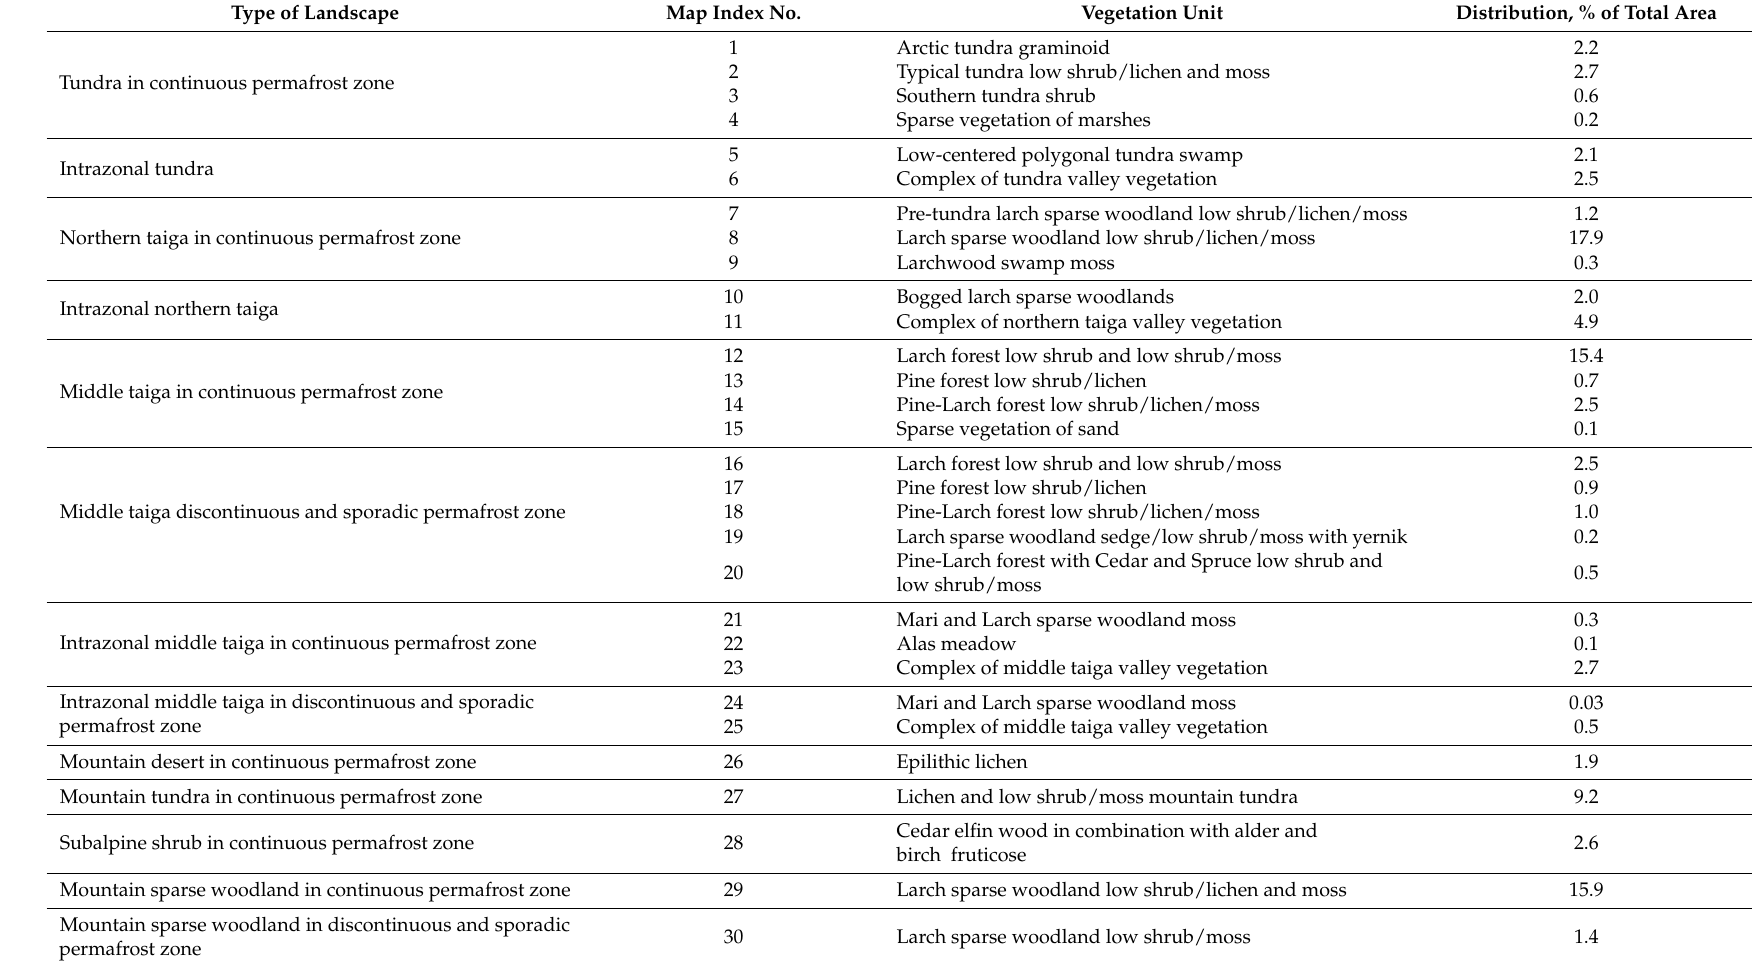
Table 3. Vegetation unit distribution in